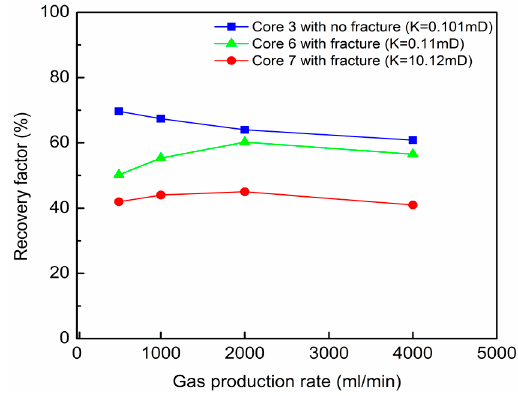
Figure 10. Recovery factor versus gas production rate for different fractures.